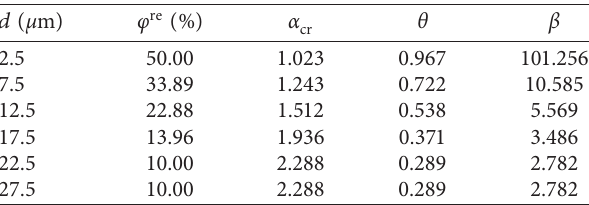
Table 13: Parameter values for con_P distribution.